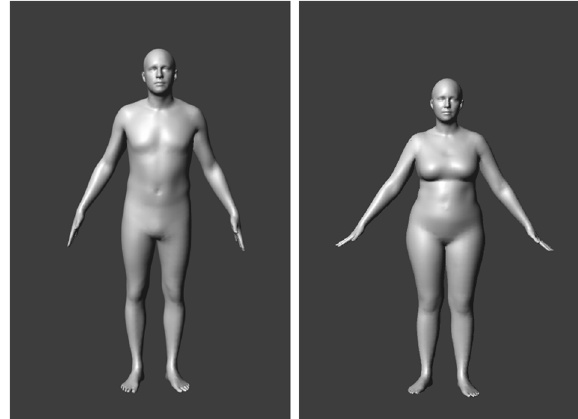
Fig. 1 Stimuli body shapes. Samples of rendered random synthetic male and female